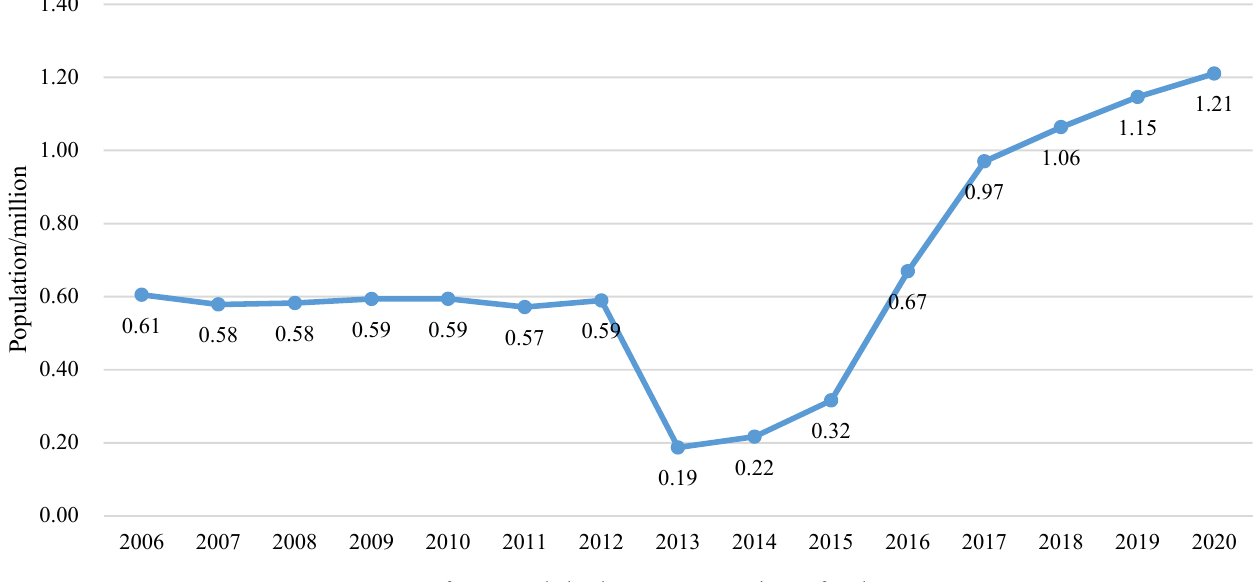
Figure 1. Diagram of the bounded rationality. Flow chart made by authors.